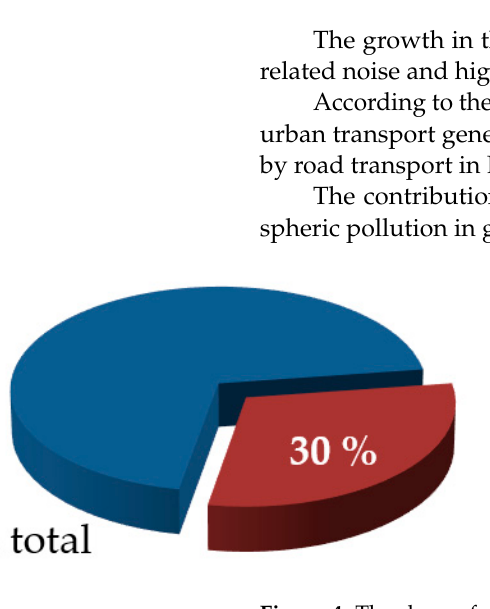
Figure 3. Predicted number of people living in cities in relation to the total population of the European Union (own research on the basis of [2]).